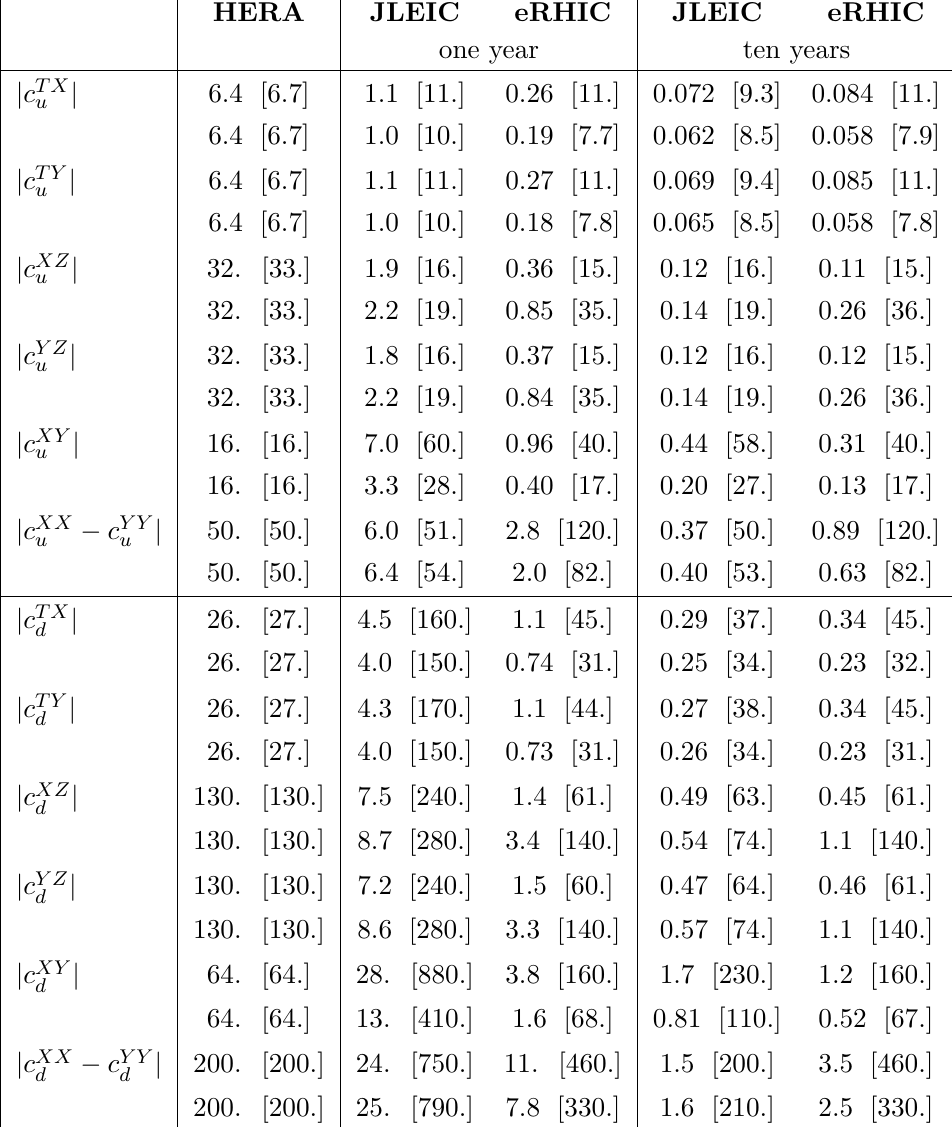
Table 1 . Best attainable sensitivities from DIS to individual coe(cid:14)cient components c (cid:22)(cid:23) estimated for HERA, JLEIC, and eRHIC. All values are in units of 10 (cid:0) 5 and re(cid:13)ect the orientation giving the greatest sensitivity. Results with brackets are associated with uncorrelated systematic uncertainties between binned data, while results without brackets correspond to the assumption of 100% correlation between systematic uncertainties. We provide estimated attainable sensitivities on coe(cid:14)cient magnitudes for both electron beam orientations, as detailed in ref. [31]. For JLEIC and eRHIC, sensitivities are listed for both one-year and ten-year data-taking con(cid:12)gurations.